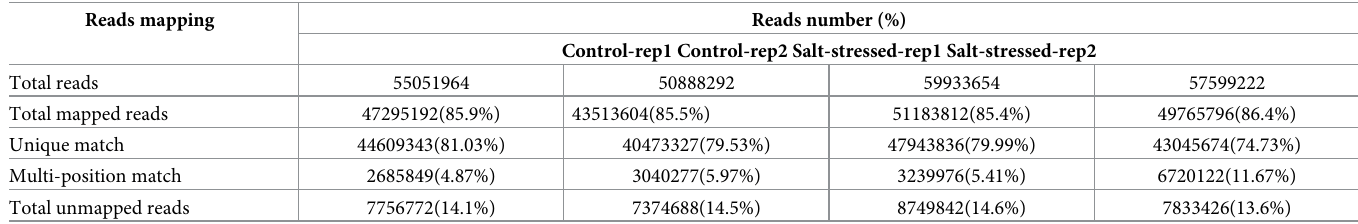
Table 1. Summary of Illumina transcriptome reads mapped to the reference genes (The numbers listed in the table are the sum of left and right reads). Reads